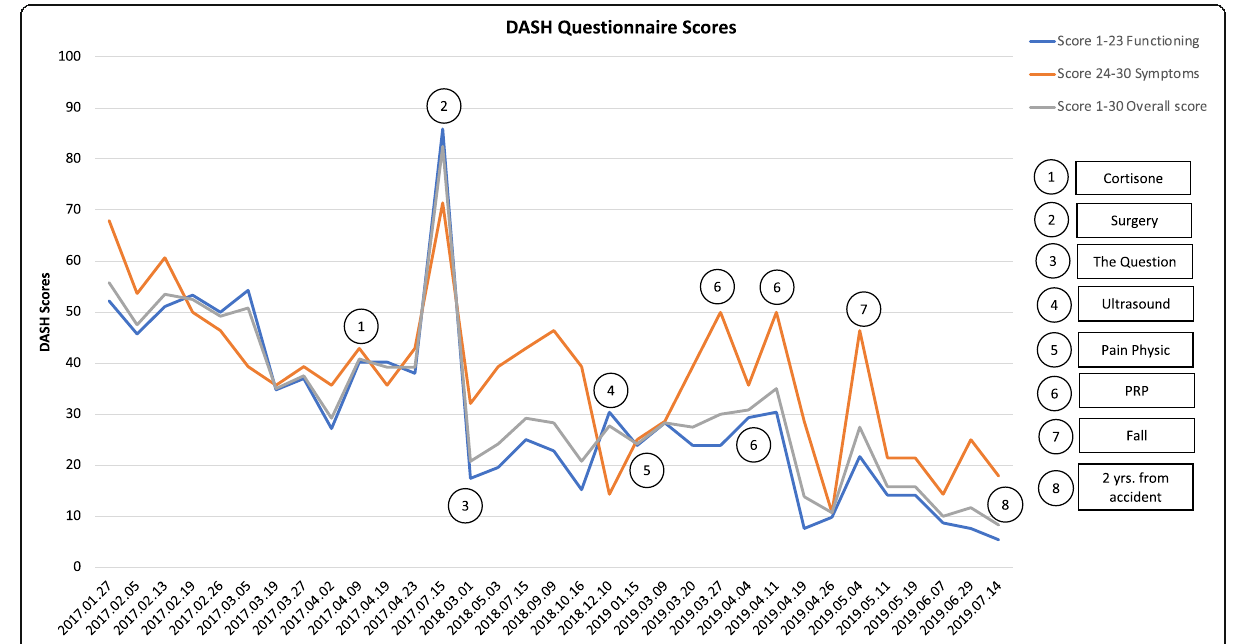
Fig. 1 Disability of Arm, Shoulder and Hand (DASH) scores 3 months to 2 years after the